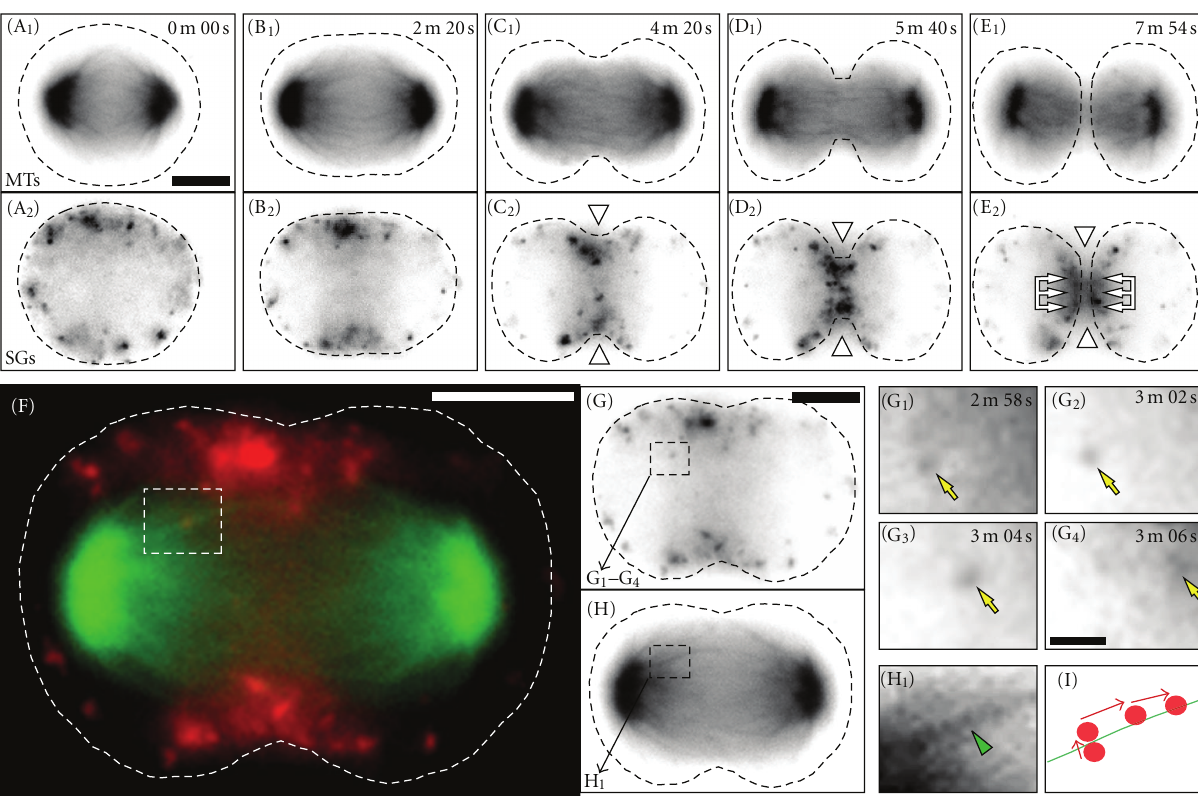
Figure 7: Dynamics of SGs during late stages of mitosis. PC12 cells were transfected with cDNAs coding for EGFP-tubulin (green) and hCgB-myc-DsRedExpress (red), synchronized and subjected to widefield fluorescence time-lapse microscopy. ((A 1 ) to (E 2 )) An overview of the progression of a typical double-transfected PC12 cell through mitosis is shown. Images (A 1 )–(E 1 ) and (A 2 )–(E 2 ) represent the EGFP-tub and hCgB-myc-DsRedExpress channels, respectively. At the end of metaphase, SGs are homogeneously distributed in the cell ((A 1 )/(A 2 )). During anaphase, SGs temporarily accumulate at sites underneath the future cleavage furrow ((B 1 )/(B 2 )). During anaphase and telophase SGs gather in the cell midzone ((C 1 )/(C 2 ) and (D 1 )/(D 2 )). At the end of telophase and beginning of cytokinesis SGs accumulate at the base of the intercellular bridge (grouped arrows in (E 2 )). Please note that the midbody in (E 1 )/(E 2 ) is out of focus. ((F) to (I)) Tracks of moving SGs colocalise with microtubules. (F) A merged overview of a selected frame from the video sequence is shown. The single channel data for microtubules and SGs is shown in (G) and (H), respectively. Magnifications from the boxed regions in (F), (G), and (H) are shown to illustrate a punctuate structure positive for hCgB-myc-DsRedExpress that was tracked through four consecutive frames ((G 1 ) to (G 4 ), arrow) and whose trajectory overlapped with a spindle microtubule (H 1 ). (I) A summary of the dynamic colocalisation of the tracked SG and the microtubule is shown. Elapsed time is given in minutes m and seconds s. Scale bars, (G 1 )–(I) 1 μ m, and all other images 5 μ m. The video sequence from which the presented images were taken is available as Supplementary Materials, Movie